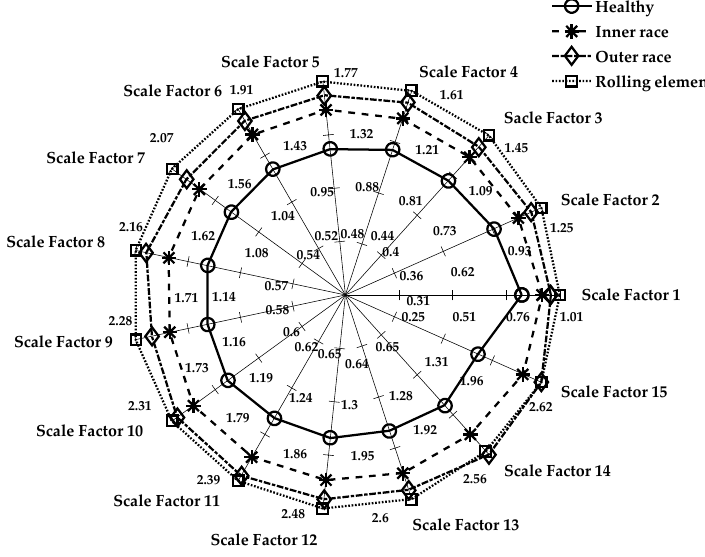
Figure 11. Spider plot for MPE of PF4 (Case 2): damage size is 0.021 inches.